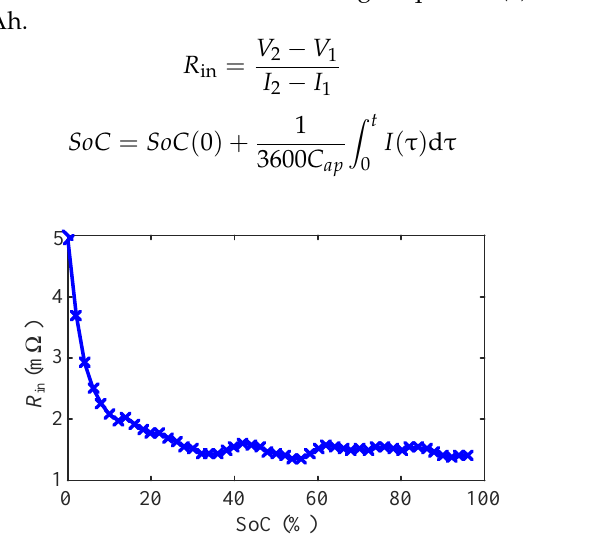
Figure 2. R in variation with different state of charge ( SoC ).